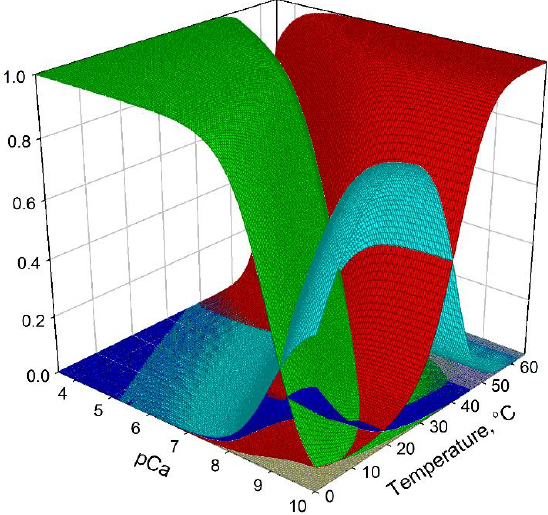
Figure 4. Three-dimensional phase diagram for bovine α-lactalbumin in free calcium (pCa = −log(Ca 2+ ))—temperature coordinates in the presence of competing Mg 2+ ions. Normalized contributions of various protein states (equilibrium Scheme 2): PCa state—green; PMg state—light blue; P*Ca state—yellow; P*Mg state—gray; P state—dark blue; P* state—red. Table 2 contains apparent binding constants of biologically significant metal cations for bovine α-LA at 20 °C. The constants were measured experimentally using the intrinsic fluorescence method without applying Scheme 1; therefore, they are apparent constants. Table 2. Apparent binding constants of biologically significant metal cations for bovine α-LA at 20 °C [11]. Metal Ion